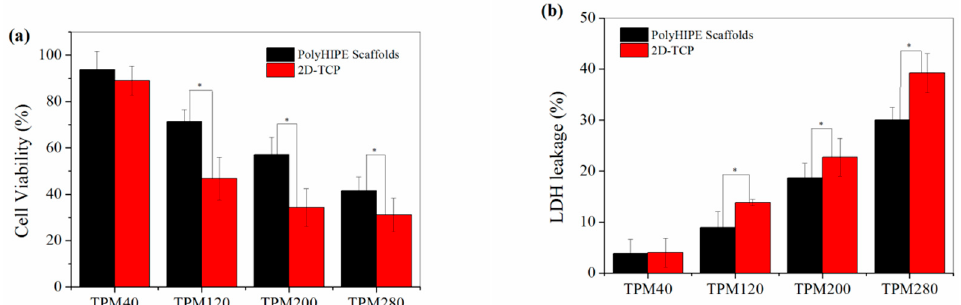
Figure 9. Cytotoxicity evaluation of cigarette smoke of 3R4F using polyHIPE scaffolds for 3D cell culture and the 2D cell culture directly on tissue culture plate (2D-TCP). ( a ) Cell viability determined by CKK-8 assay under TPM expose with 40–280 µg/mL dose; ( b ) LDH leakage under TPM expose with 40–280 µg/mL dose. * Significantly difference p < 0.05 (equal variance t -test).